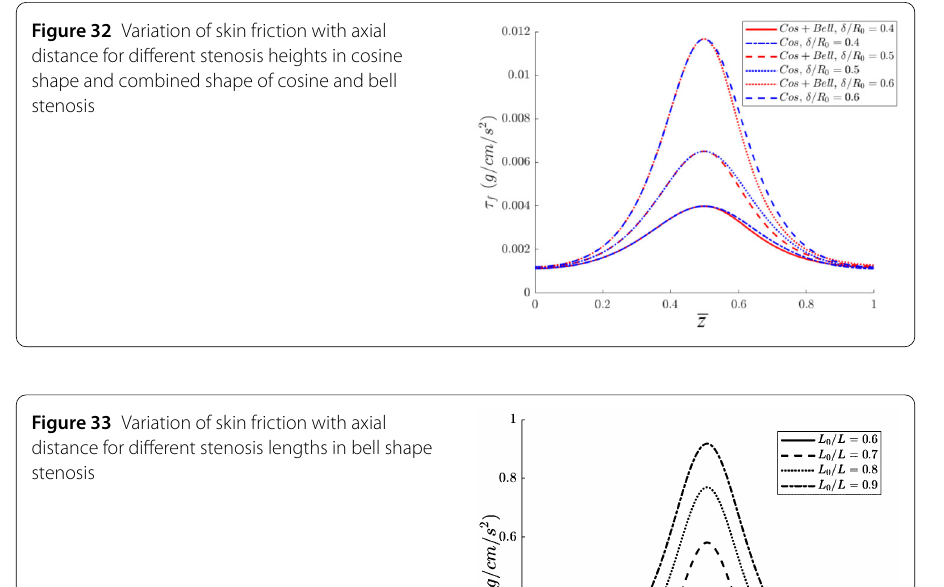
Figure 32 Variation of skin friction with axial distance for different stenosis heights in cosine shape and combined shape of cosine and bell stenosis